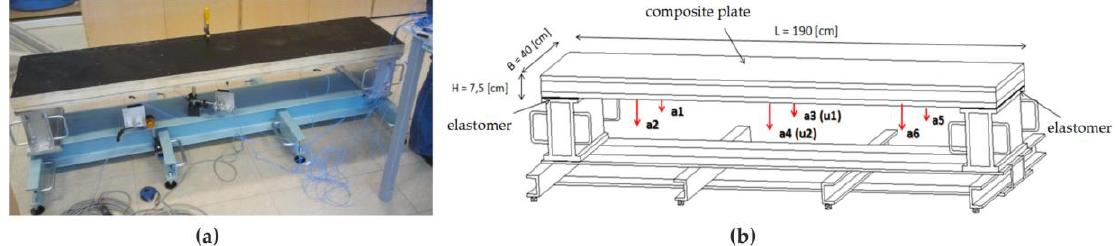
Figure 11. Experimental setup: ( a ) general view, ( b ) geometry of the tested plate and the location of points for measurement of accelerations (a1 to a5) and displacements (u1, u2).